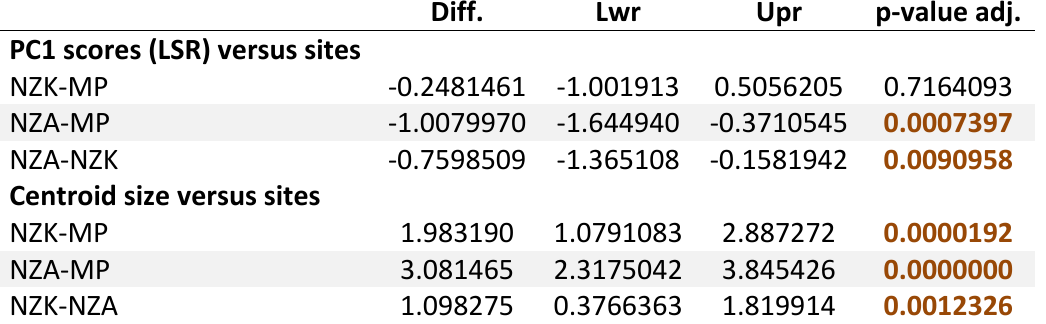
Table 8. Results of the post-hoc Tukey HSD tests conducted on PC1 and PC2 scores (LSR) and centroid size versus sites for the whole assemblages. Significant values are in bold. diff. : difference in the observed means, lwr : lower end point of the interval, upr : upper end point of the interval, p-value adj : p-value after adjustment for the multiple comparisons. Diff.